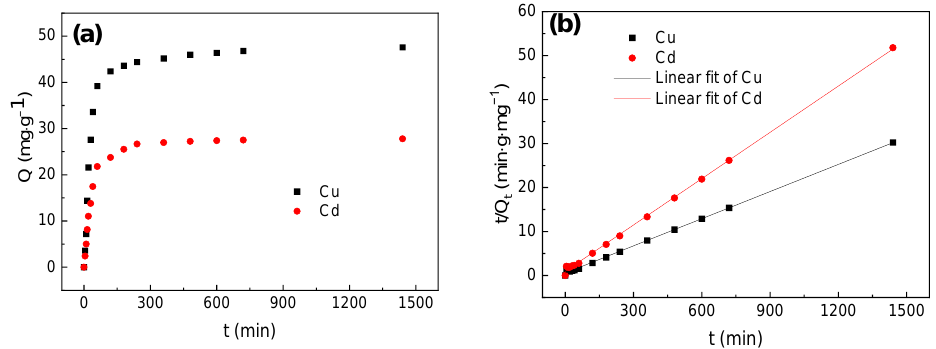
Figure 4. ( a ) BHW adsorption of Cd 2+ and Cu 2+ ions change curve with adsorption time; ( b ) Linear fitting diagram of pseudo-second-order rate equation.